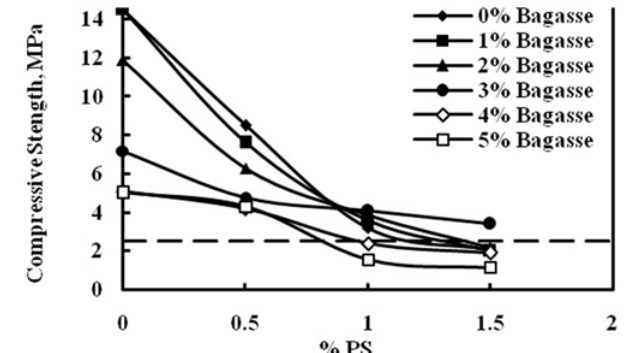
Figure 11. Effect of percent PS and bagasse addition on cold crushing strength